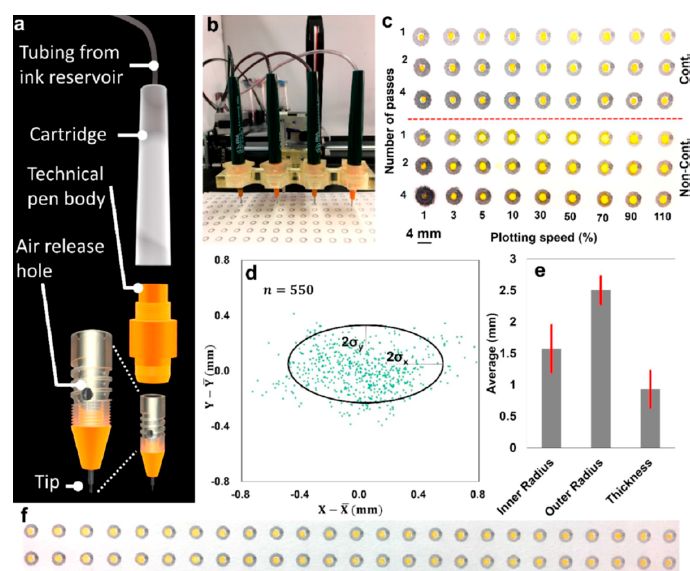
Figure 9. ( a ) Illustration of the continuous ink technical pen. ( b ) Technical pens fed continuously by ink. ( c ) The effects of different plotting speeds and numbers of passes on the water resistance of patterns in a continuous ( top ) and noncontinuous ( bottom ) plotting system. ( d ) Deflection of the plotted patterns in both the x and y directions. (e) comparison of the dimensions of the printed spots by the pen ‐ plotter. ( f ) A representative image shows the performance of the continuous plotting system in high ‐ throughput fabrication of paper ‐ based microfluidics. (Adapted with the permission of American Chemical Society) [63].